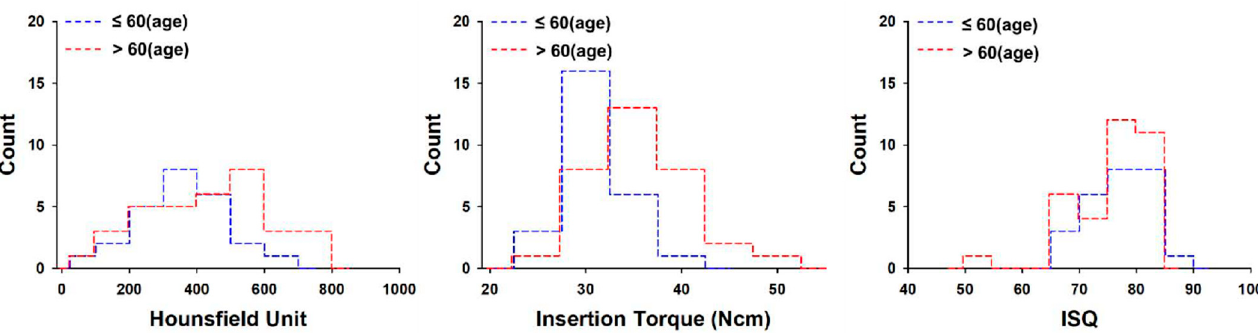
Figure 4. Histogram of average Hounsfield units, maximum insertion torque, and implant stability quotient values with patient age. ISQ = implant stability quotient.